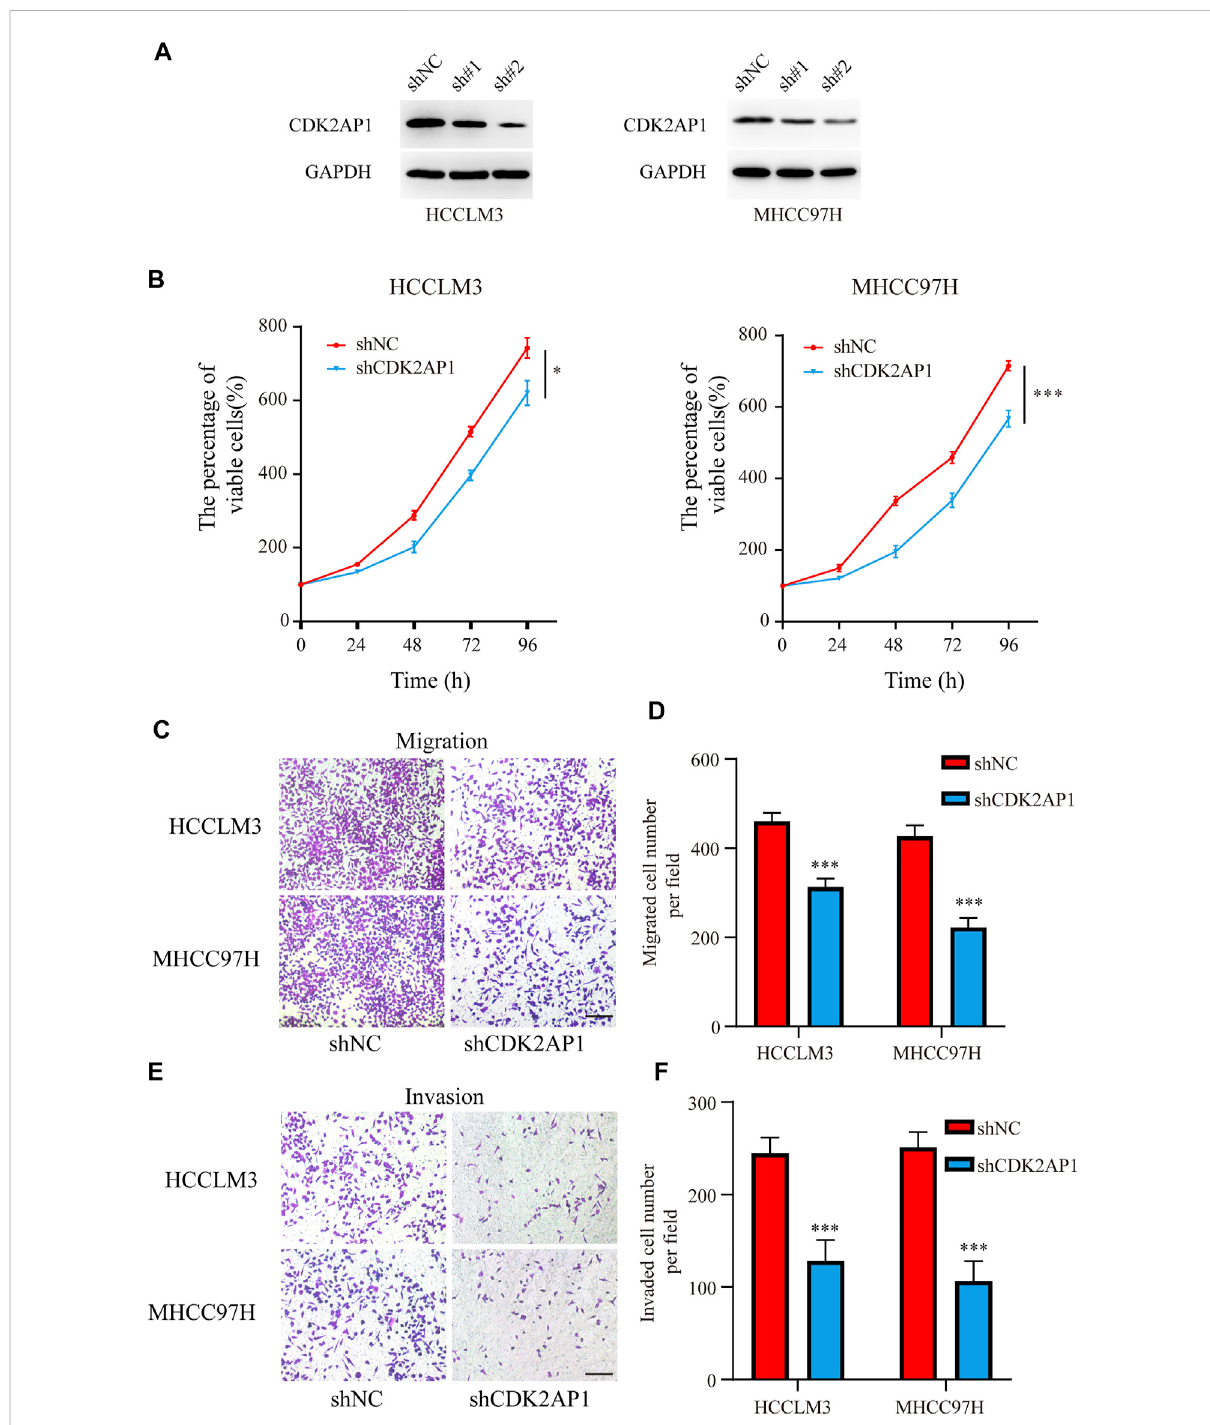
FIGURE 7 CDK2AP1 promotes proliferation and migration of HCC cell lines in vitro (A) Western blotting of CDK2AP1 in HCCLM3 and MHCC97H cells transfectedwithCDK2AP1-shRNA (B) ProliferativecurveofHCCLM3andMHCC97Hcellsatindicatedtimes (C) The migrationassay ofHCCLM3 and MHCC97H cells in two groups (D) Quanti fi cation of the migration ability (E) The invasion assay of HCCLM3 and MHCC97H cells in two groups (F) Quanti fi cation of the invasion ability. * p < 0.05, ** p < 0.01 and *** p <